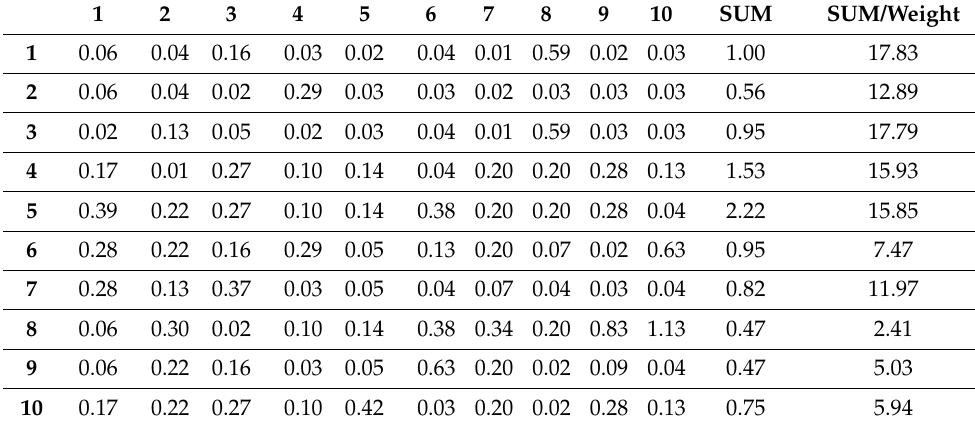
Table 6. The calculation of coherence index ( CI ) random consistency